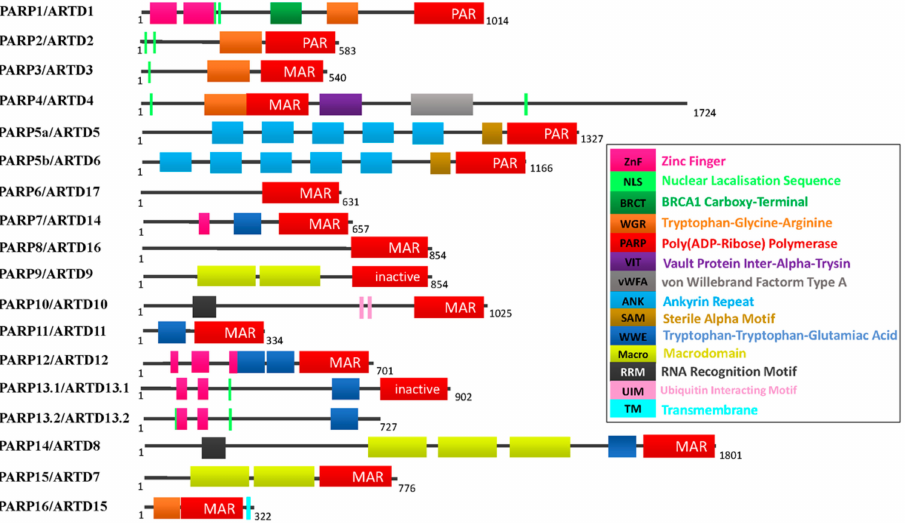
Figure 1. The PARP superfamily. Di ff erent color boxes indicate protein